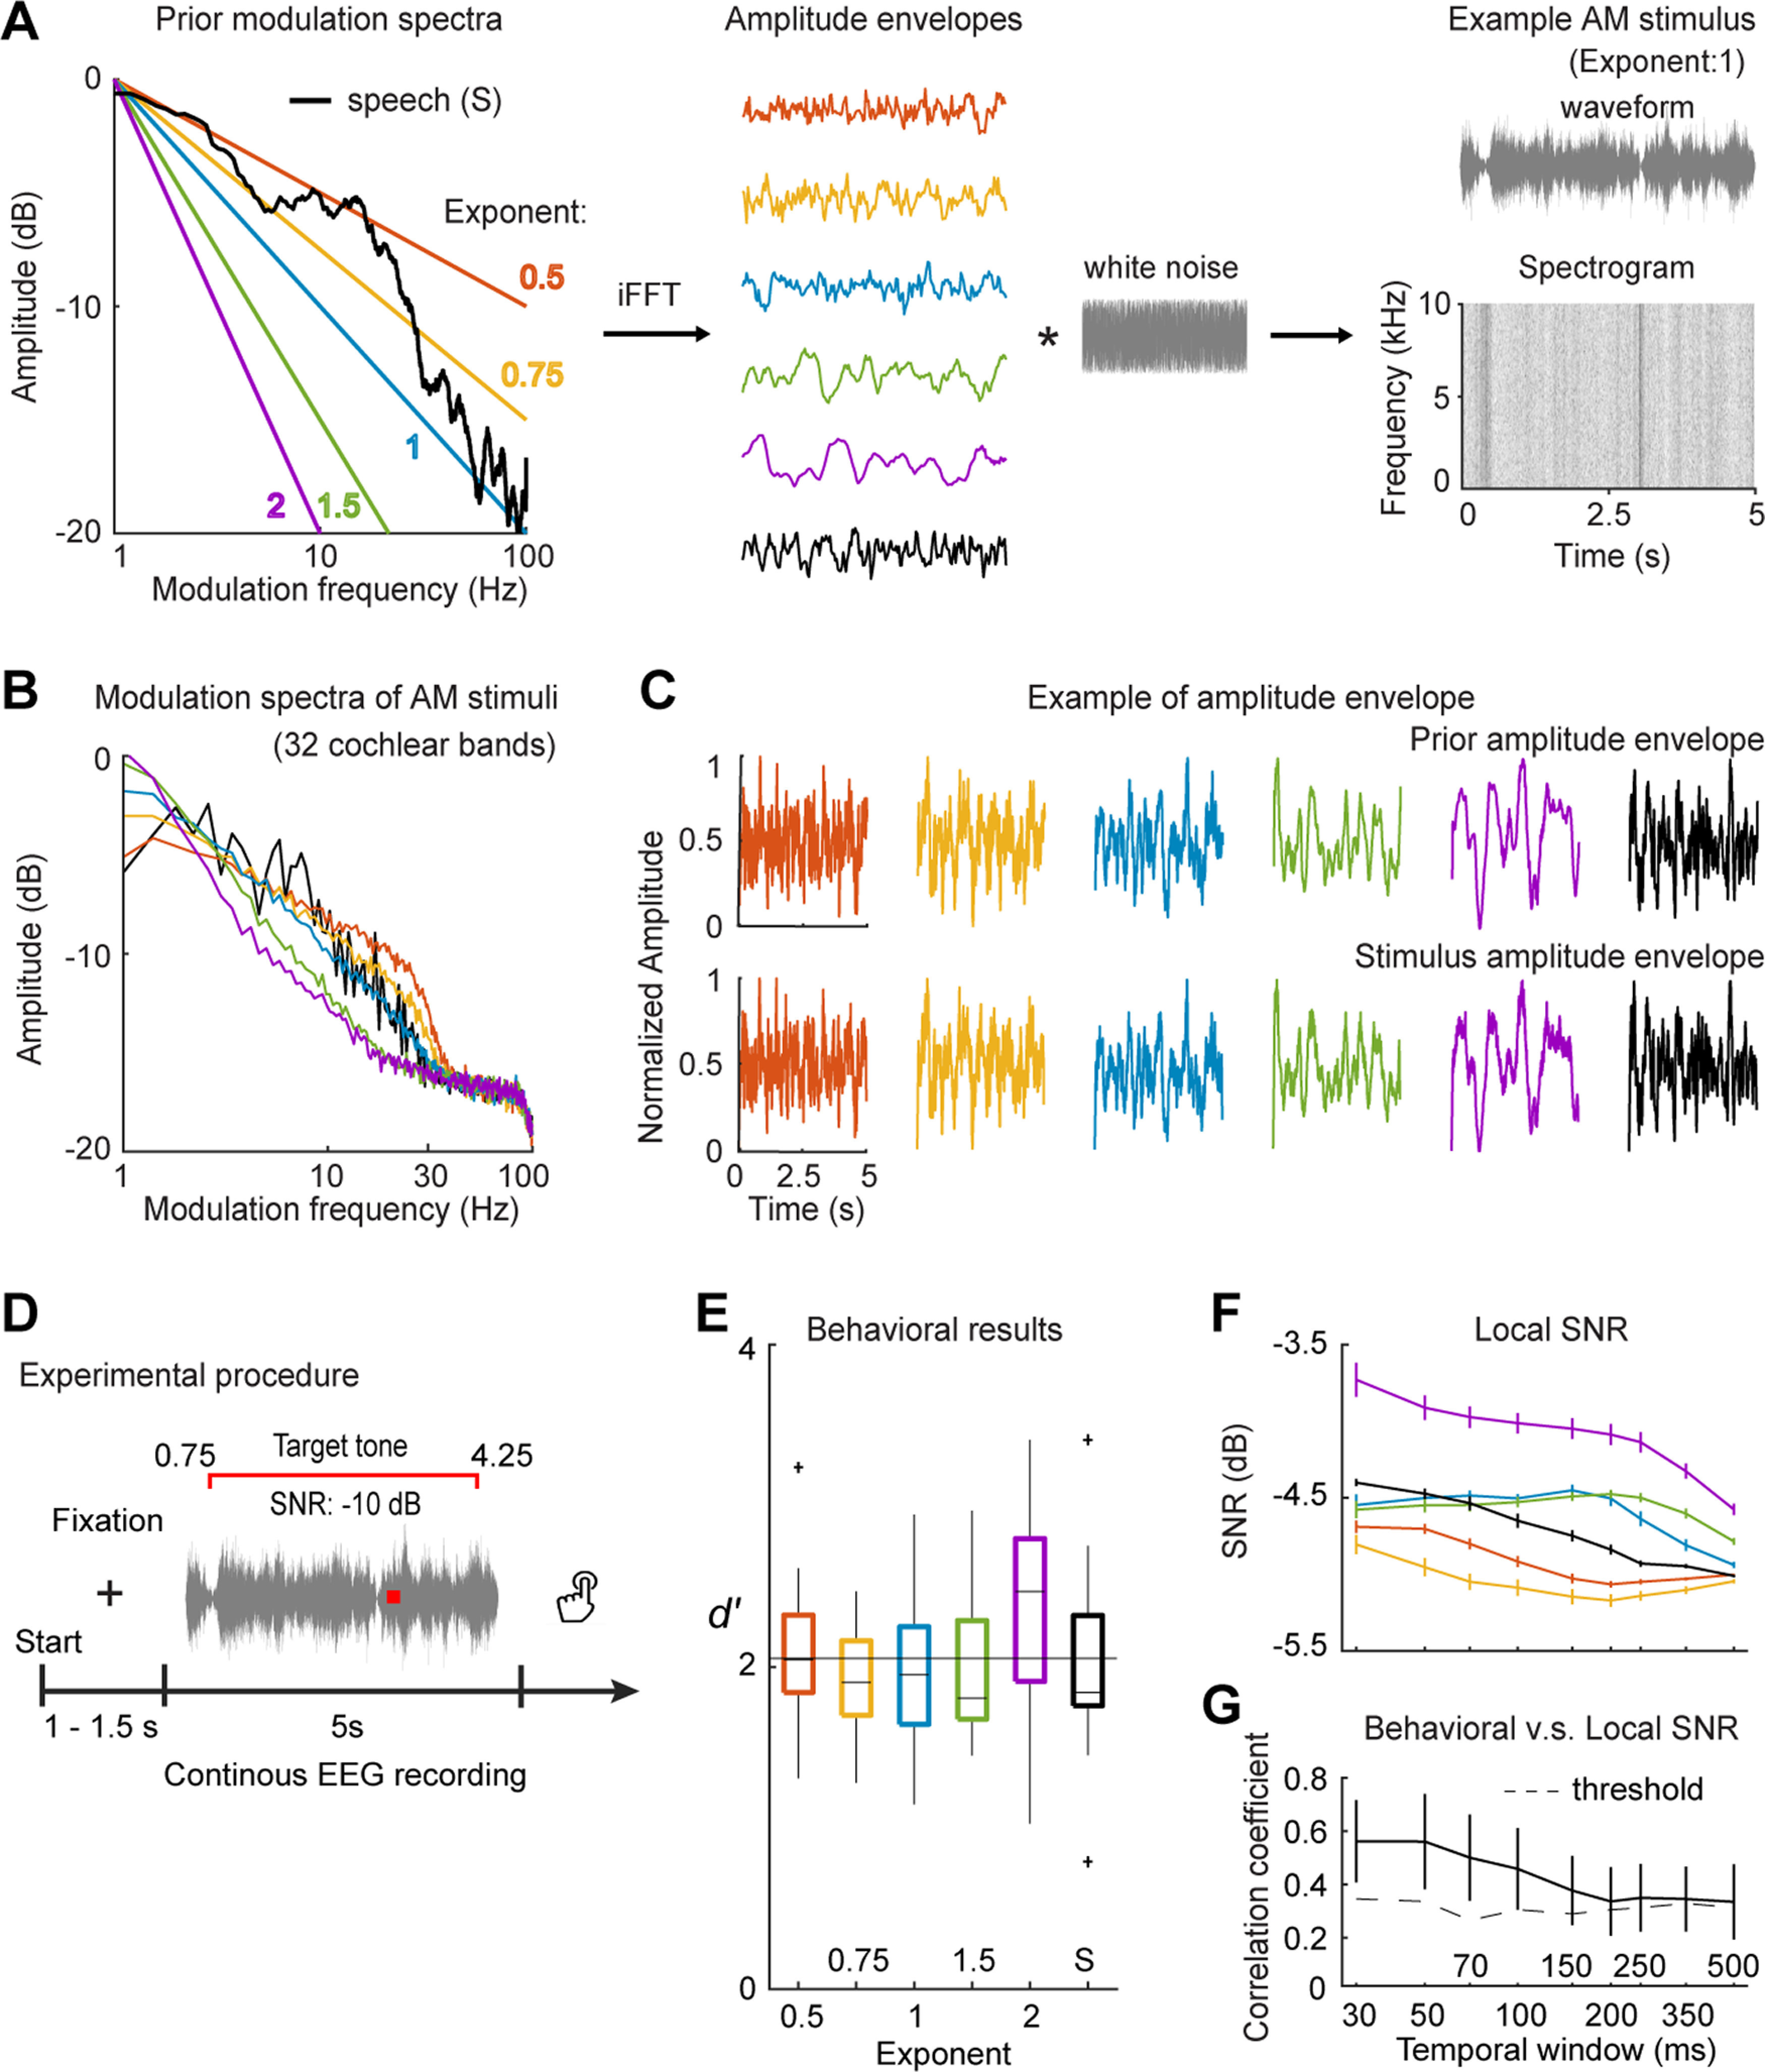
Stimulus generation, experimental paradigm, and behavioral results. A, AM stimulus generation. The left panel shows the modulation spectra used to generate AM envelops. The line color codes for different modulation spectra. An example of each AM envelope is shown in the middle panel. We filtered the AM envelopes through a bandpass filter of 1–30 Hz and then modulated broadband white noise with the AM envelopes to create AM stimuli. An example waveform of the AM stimuli with a 1/f modulation spectrum of exponent 1 is shown in the upper right panel. The spectrogram of the example AM stimulus is shown in the lower right panel. B, Modulation spectra of AM stimuli. We extracted amplitude envelopes of each AM stimulus and then converted the envelopes to modulation spectra for each AM type. It can be seen that the trends of the prior modulation spectra were preserved in the modulation spectra of the AM stimuli. C, Examples of prior AM envelopes and the AM envelopes from the AM stimuli. The upper row shows examples of the prior AM envelopes and the lower row shows the AM envelopes extracted from the AM stimuli. D, Experimental paradigm for presenting AM stimuli during EEG recording. E, Box plot of behavioral data. D-prime values were calculated to quantify the performance of tone detection. The thin black line indicates the threshold of significance (α level of 0.01) derived from a permutation test (for more details, see Results). F, Local SNR of tones in the AM stimuli. We calculated local SNRs using temporal windows of different sizes. The line color codes for different AM types as in A. G, Correlation between behavioral data and local SNR. The dashed line represents the threshold of significance (α level of 0.01) derived from a permutation test (for more details, see Results). The results show that the shorter the temporal window is, the better the local SNR explains the behavioral performance. The error bars in F, G represent ±1 SE over participants. The AM stimuli can be found in the OSF project folder https://osf.io/yp4k3/.